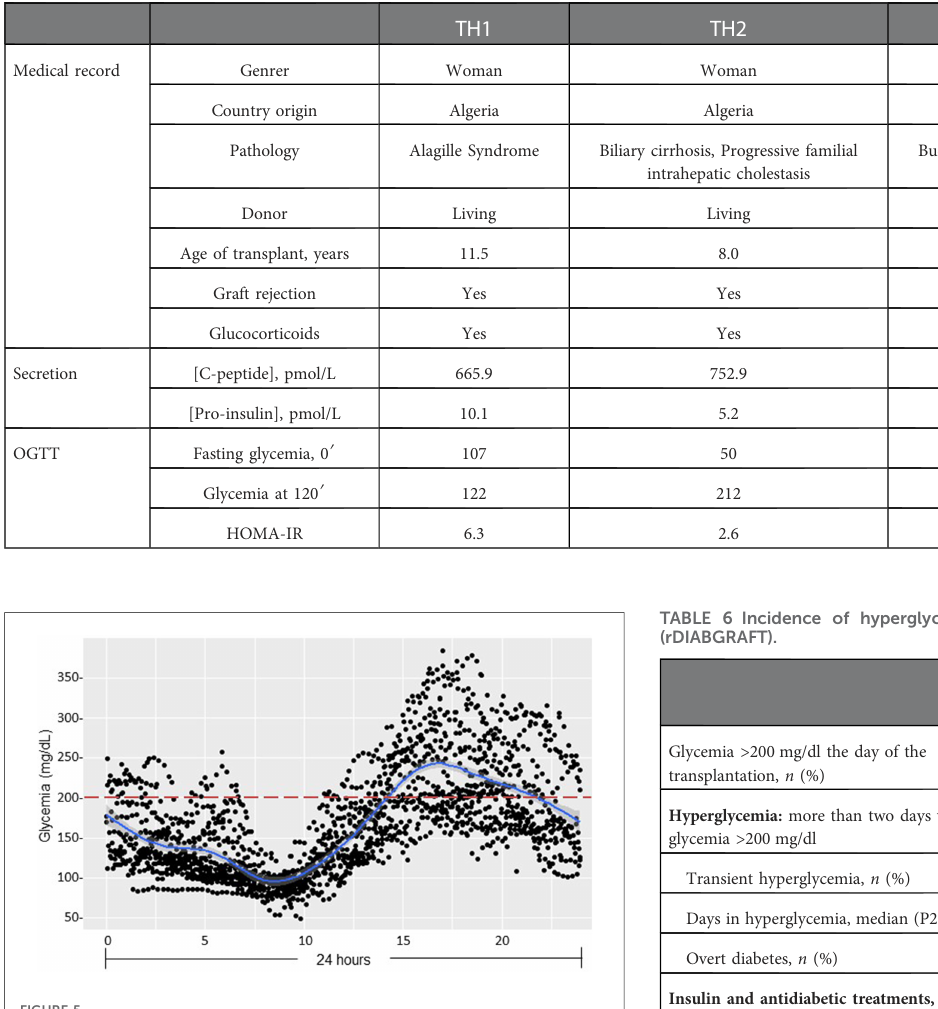
FIGURE 5 Continuous glucose monitoring after pediatric liver transplantation (pDIABGRAFT). Data of the continuous glucose monitor placed at day 14 post-LT for one month were regrouped on 24 h and showed chronic hyperglycemia occurring in postprandial afternoon period.